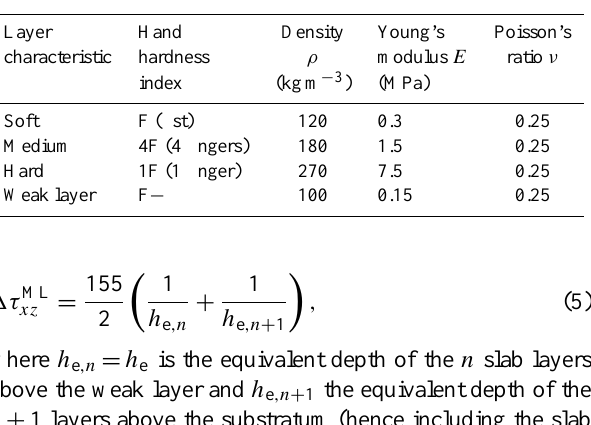
Table 1. Material properties of the layers for the simplified snow profiles.